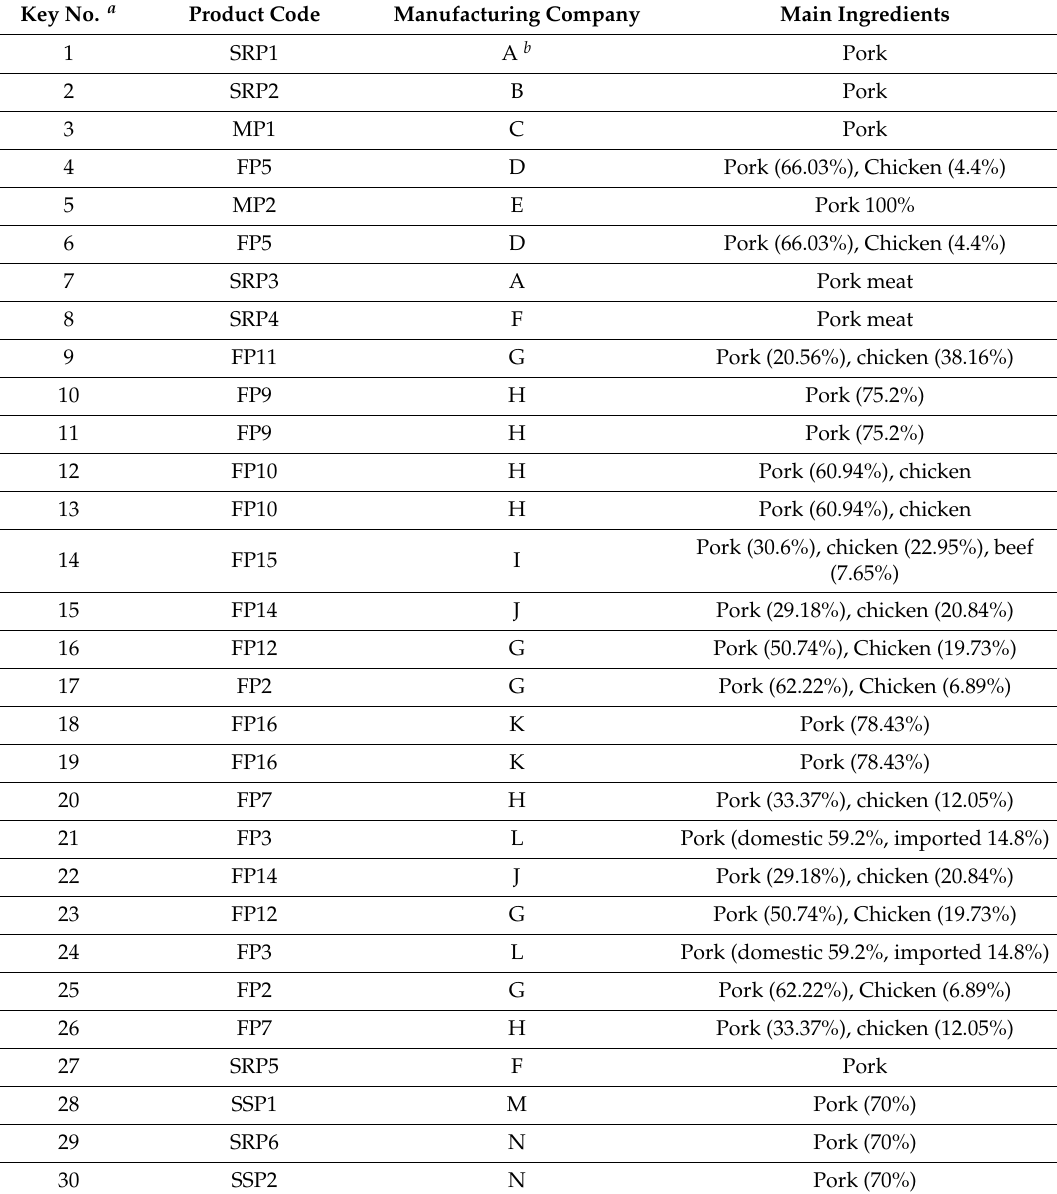
Table 4. Information on the pork meat products analyzed for E.